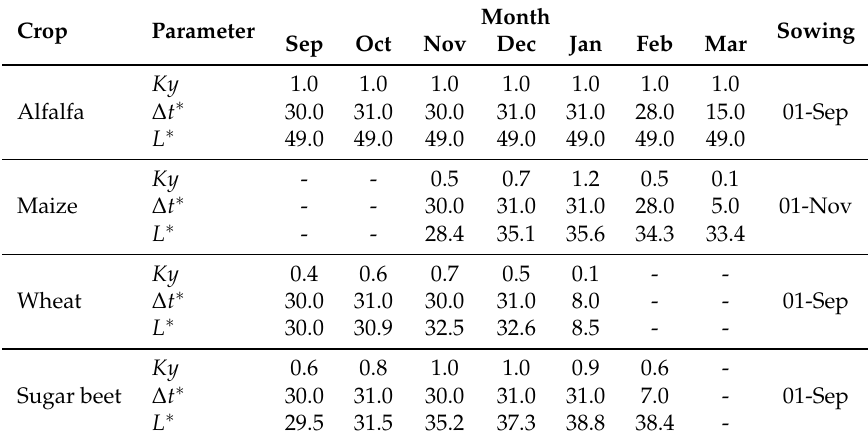
Figure 2. Study area location. The right-bottom panel shows available water based on streamflow records of a distribution channel. Table 1. Parameters used for monthly crop yield functions based on the CROPWAT 8.0 database and the sowing date recommended by Faiguenbaum [43].